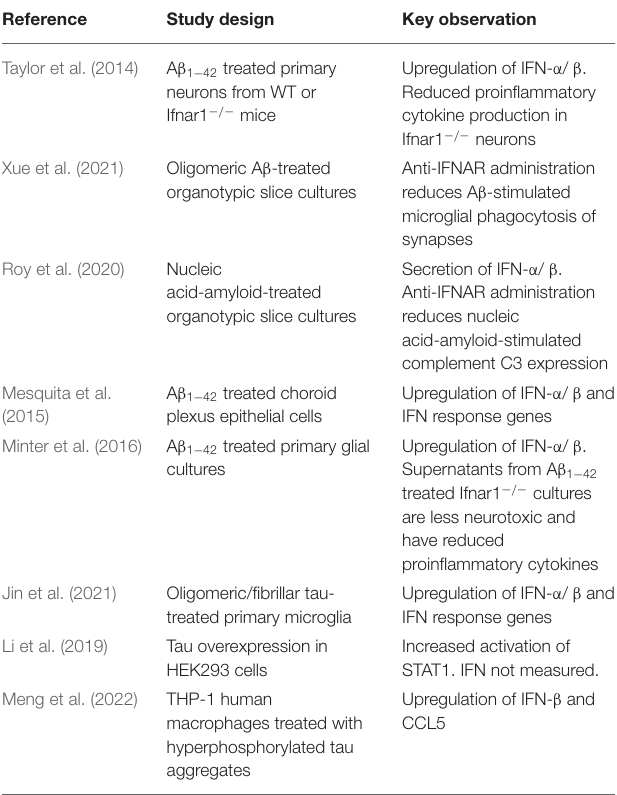
TABLE 1 | Summary of studies addressing the production of type-I IFNs in ex vivo and in vitro models of AD and tauopathy.